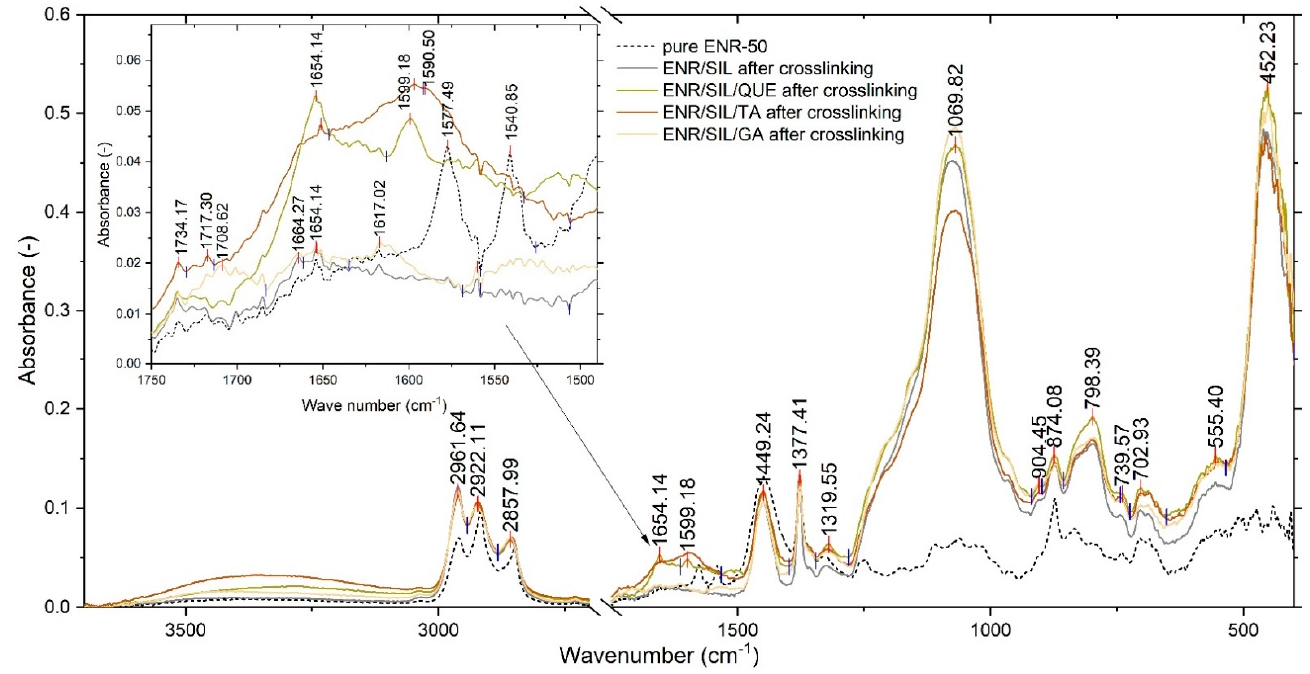
Figure 5. Comparison spectrum of ENR/silica hybrid containing natural phenolic compounds with spectra of pure ENR/silica hybrid.